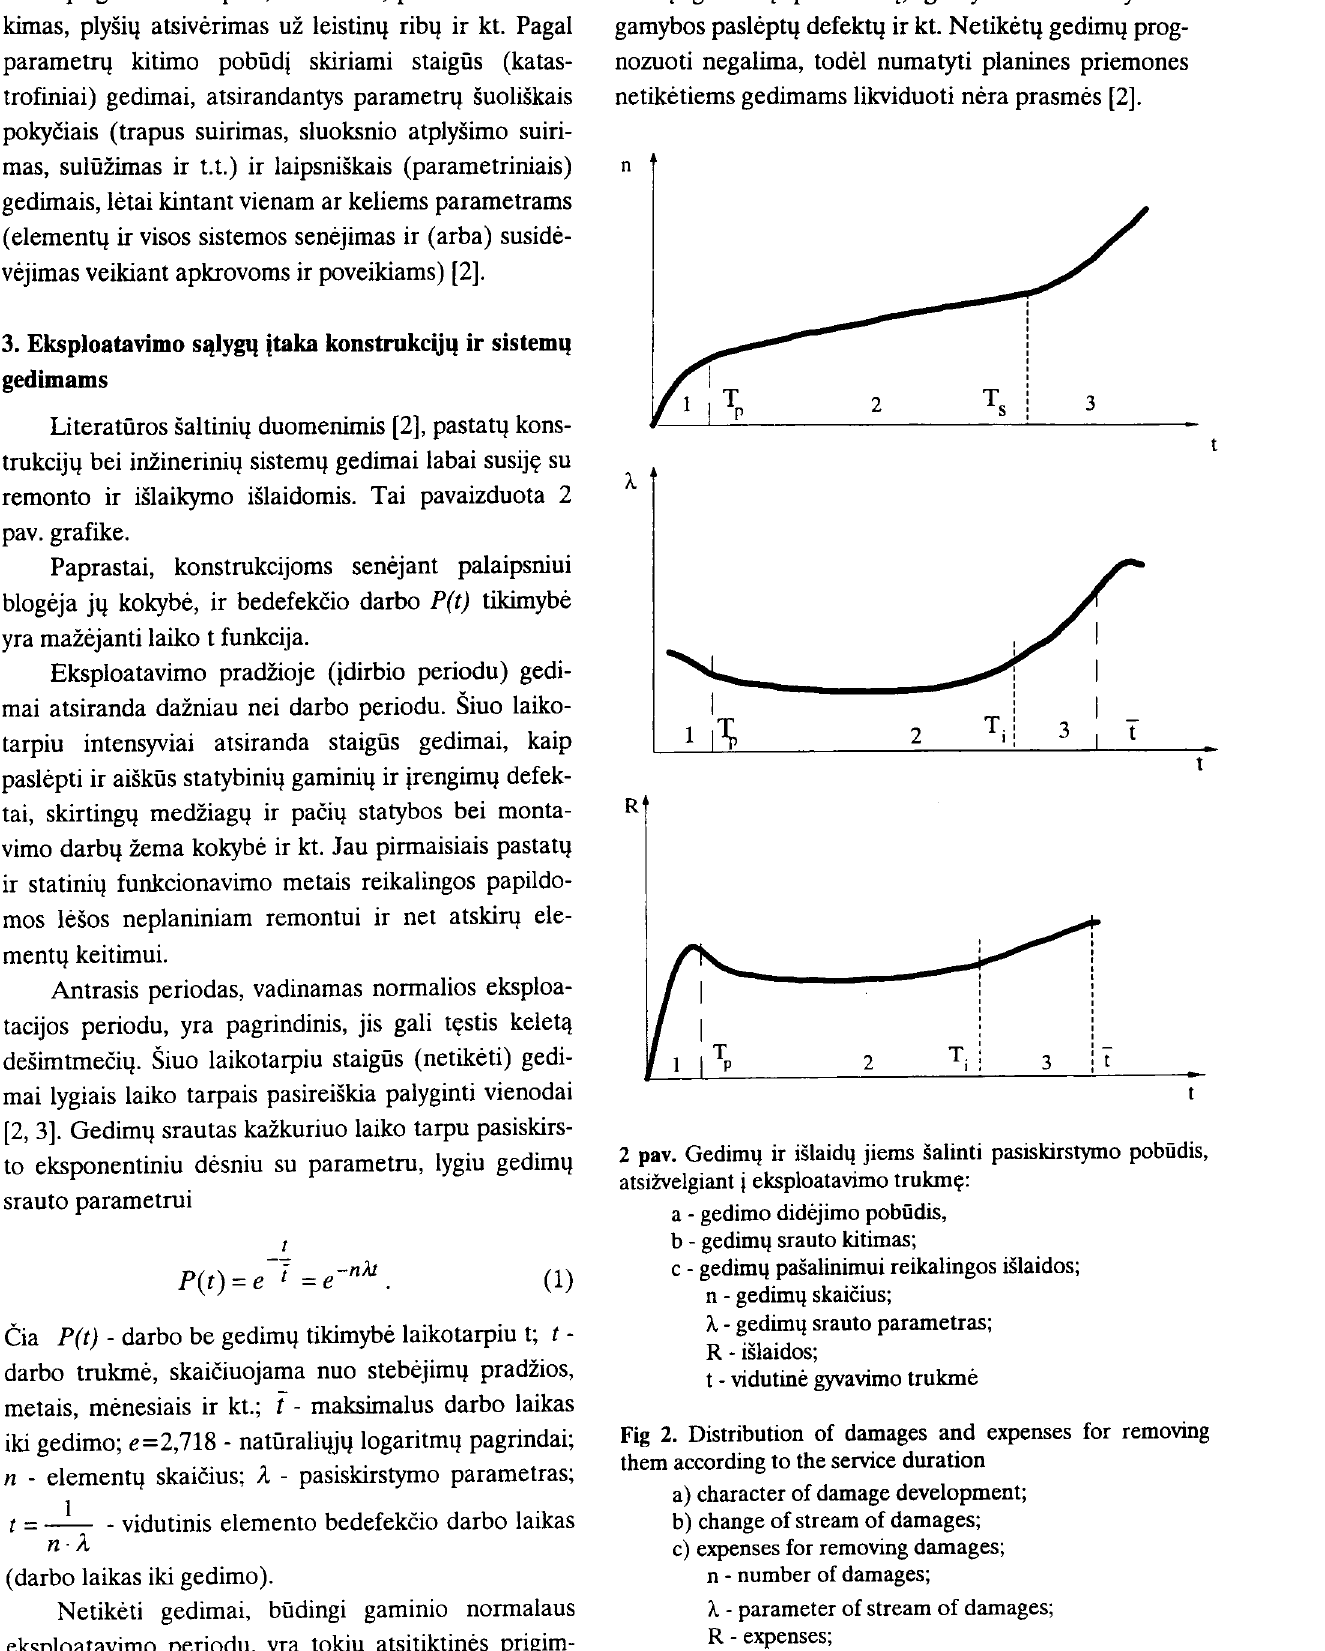
Fig 2. Distribution of damages and expenses for removing them according to the service